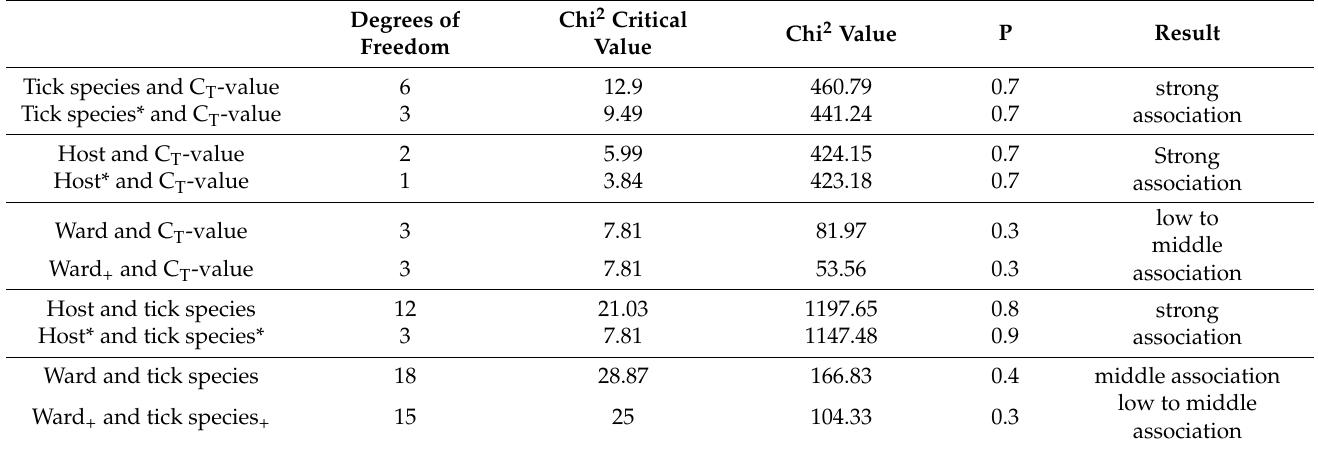
Table 4. Results of the Chi 2 test and the adjusted Pearson’s coefficient of contingency (P).